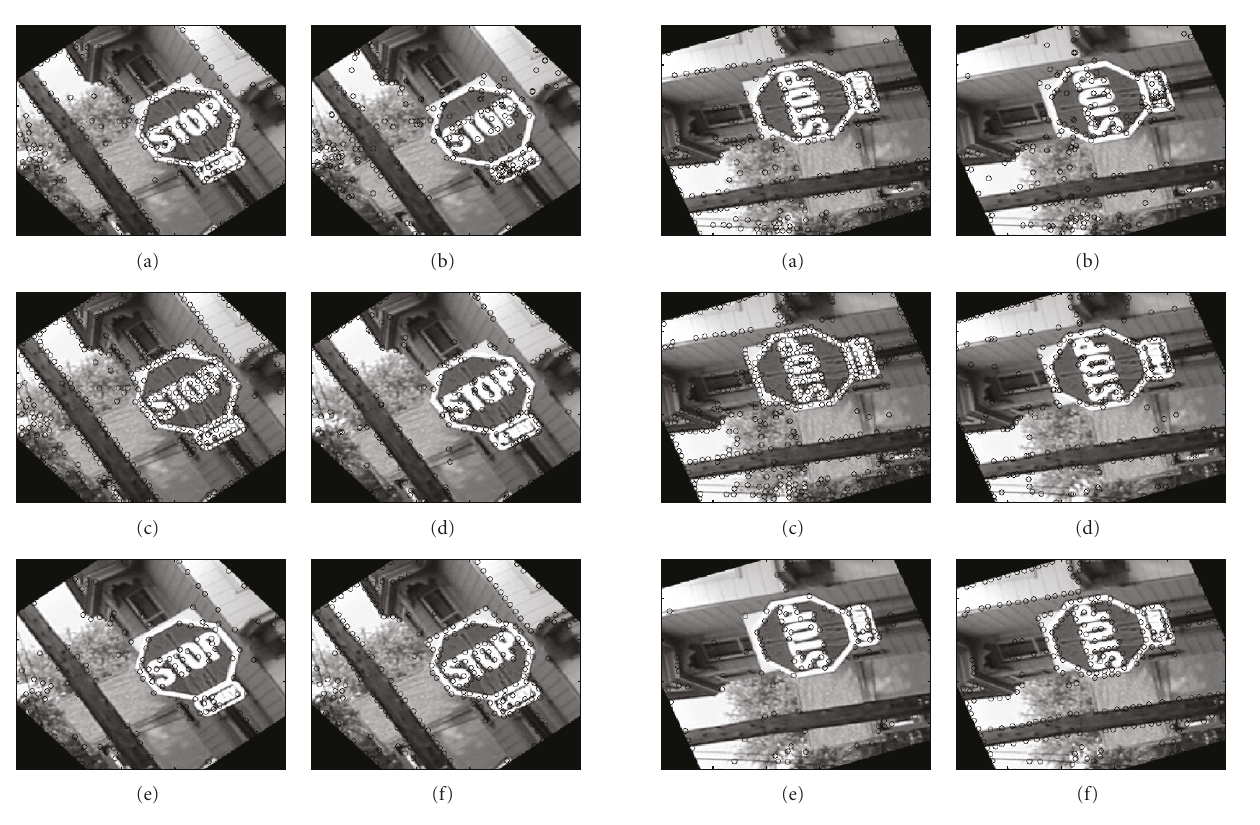
Figure 7: Feature points detected in 40 ◦ rotated image by (a) Harris method (b) Lowe’s method, (c) Tomasi’s method, (d) Loupias’s technique, (e) Yeh’s algorithm, and (f) proposed technique.